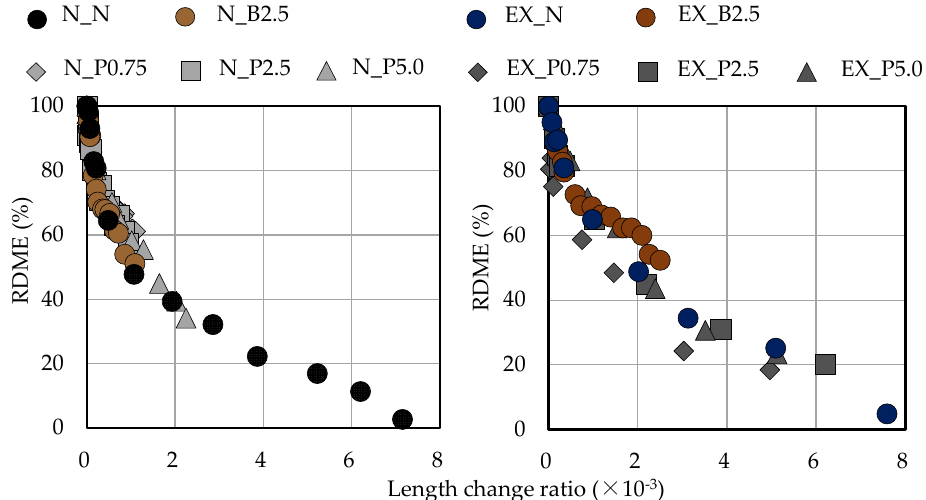
Figure 12. Relationship between RDME and length-change ratio in ordinary and expansive mortars. (black: without NFBC, brown: with NFBC type B f , grey: with NFBC type P f )